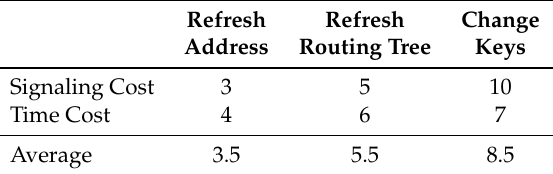
Table 9. Countermeasure cost for sensor